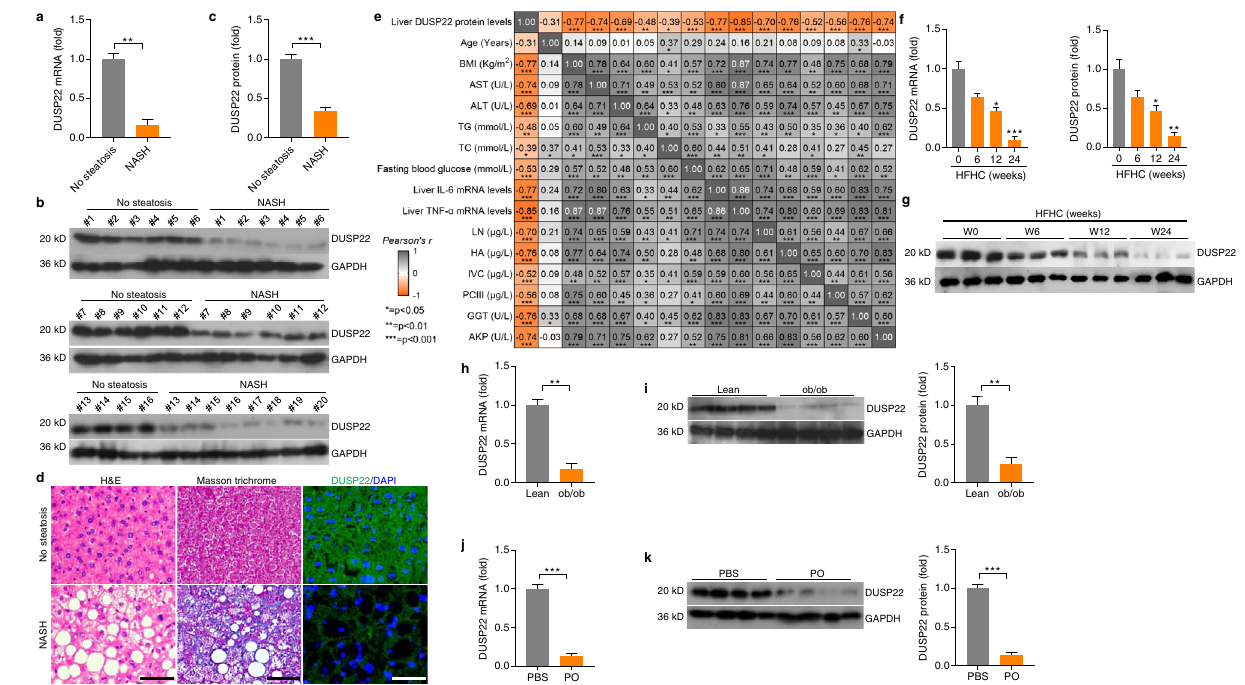
Fig. 1 | DUSP22 is downregulated in fatty liver. a RT-qPCR analysis for DUSP22 mRNA levels in livers of individuals without (No steatosis; n =16) or with NASH ( n =20) (** P <0.01). b , c Representative western blotting analysis ( b ) and quanti fi - cation ( c ) of DUSP22 protein expression in livers of individuals without (No stea- tosis; n =16) or with NASH ( n =20) (*** P <0.001) . d Liver sections from individuals without (up) or with NASH (down) were stained with H&E (left),Masson trichrome (middle) and immuno fl uorescence (right) examination for DUSP22 expression (green) ( n =8 per group, with 10 images for each sample; Scale bars, 50 µ m). e Pearson multiple correlation among all parameter indexes gathered from No steatosis and NASH individuals ( n =36 per parameter). Orange color shows nega- tive correlation, gray color shows positive color correlation; strong colors tonality identi fi esstrongestcorrelation. f , g Analysisof f RT-qPCRand g westernblottingfor